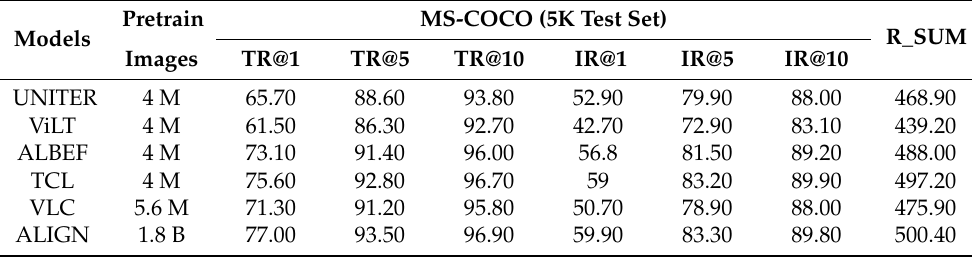
Table 6. Cross-modal retrieval performance comparison on MS-COCO (5K test set).